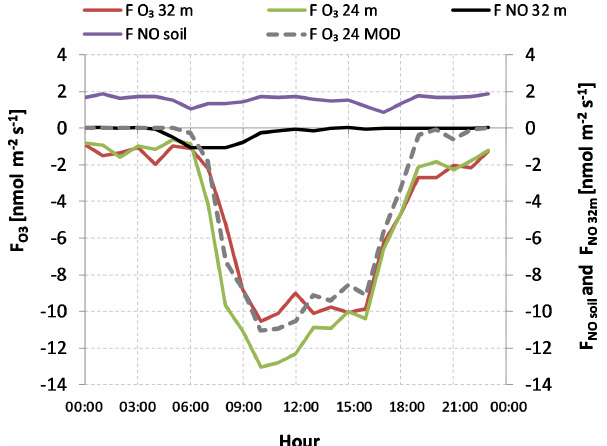
Figure 8. Average diel course of O 3 fluxes at 32m (red line), O 3 fluxes at 24m (green line), NO fluxes at 32m (black line), NO fluxes at soil level (purple line) and the modified (MOD) O 3 fluxes at 24m (dashed grey line). This latter takes into account the role of the NO- related sink.